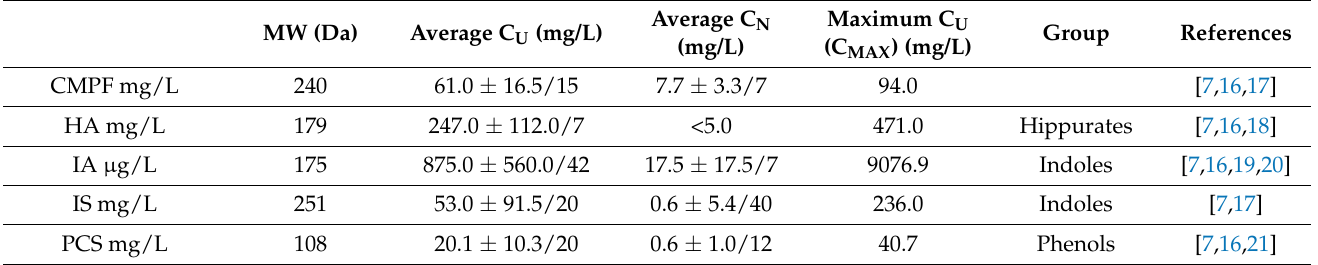
Table 2. Retention solutes second group: low molecular weight (<500 D) with known protein binding.